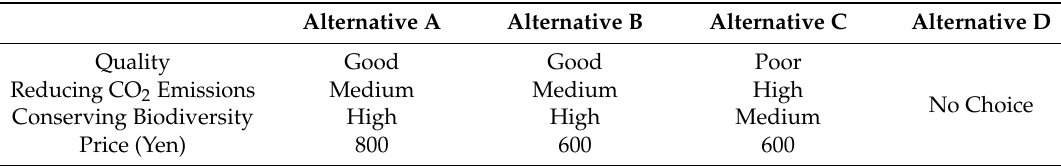
Table A1. An example of the CE